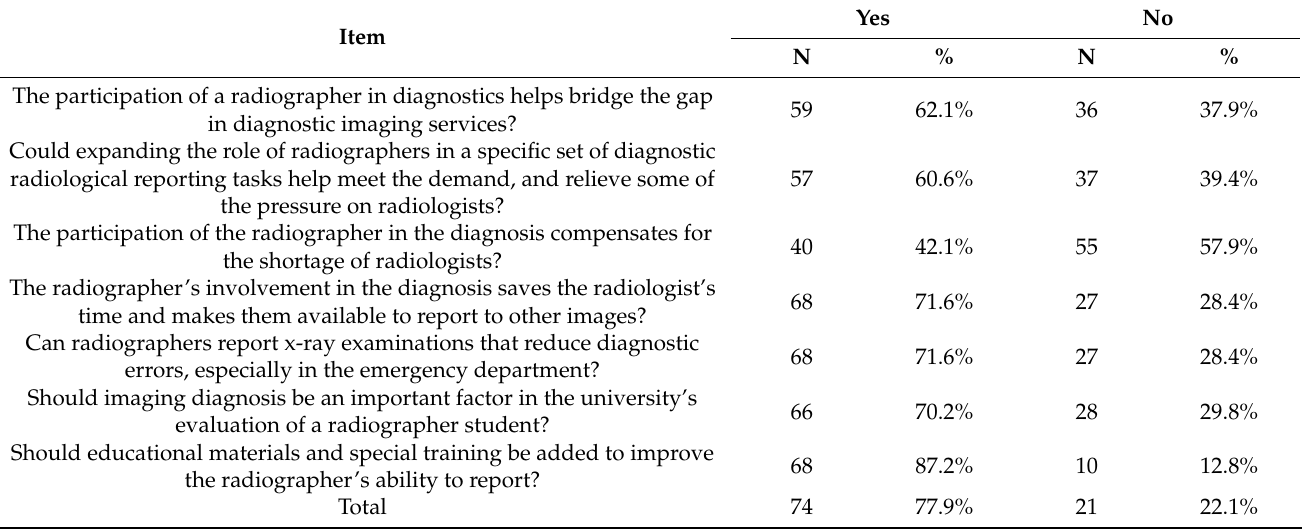
Table 3. Frequencies and percentages of radiologists and radiographers about to what extent the participation of radiologists in diagnosing can be useful, and whether they have sufficient experience and education to participate in this system (n =